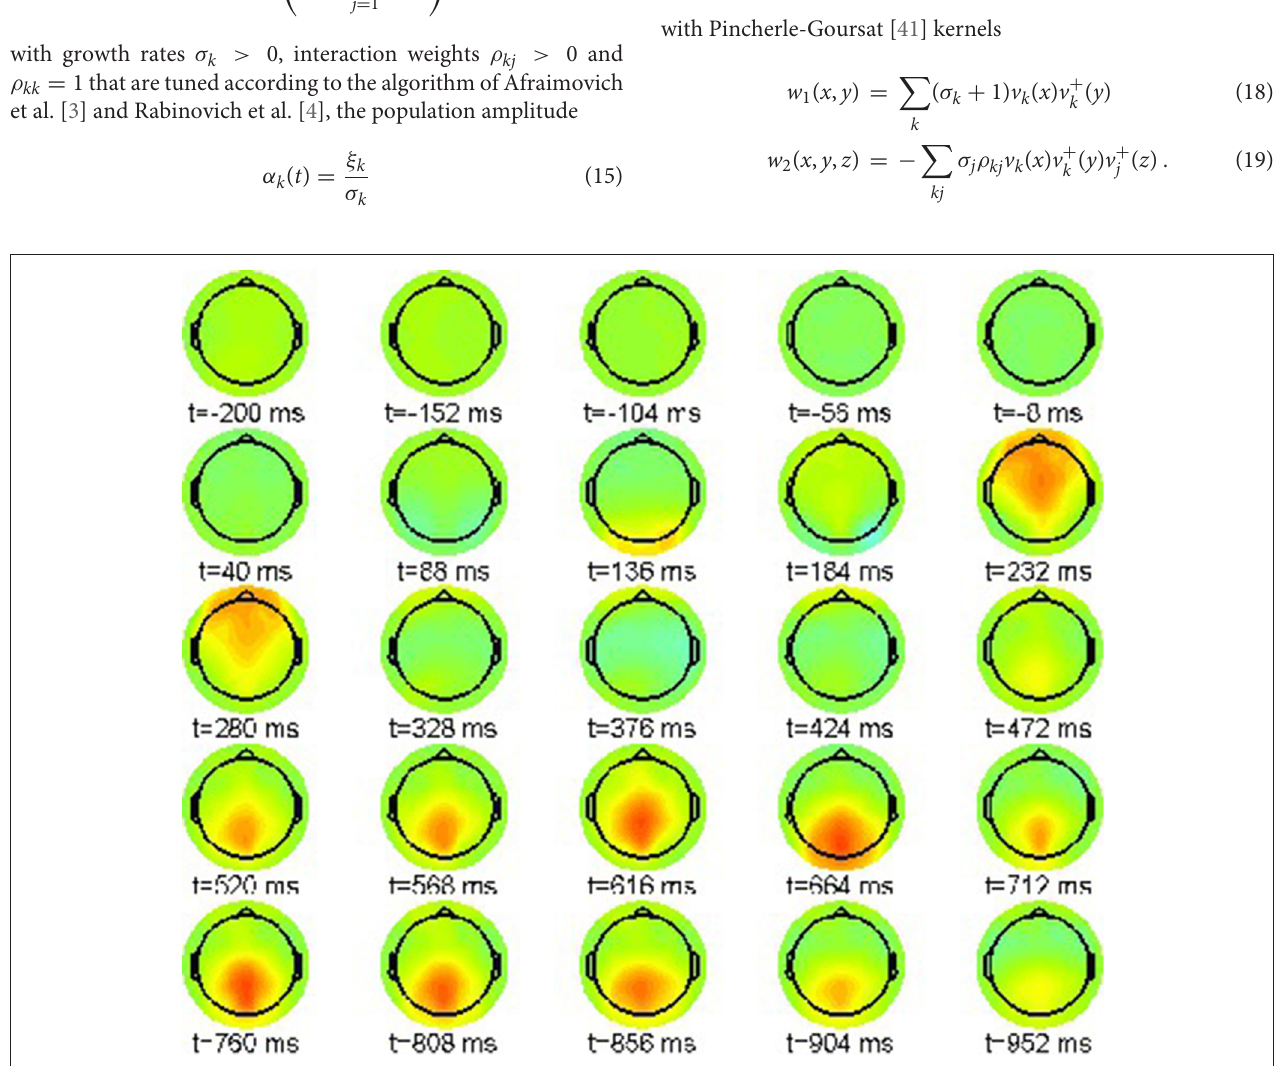
FIGURE 2 | Snapshot sequence of ERP scalp topographies for violation condition